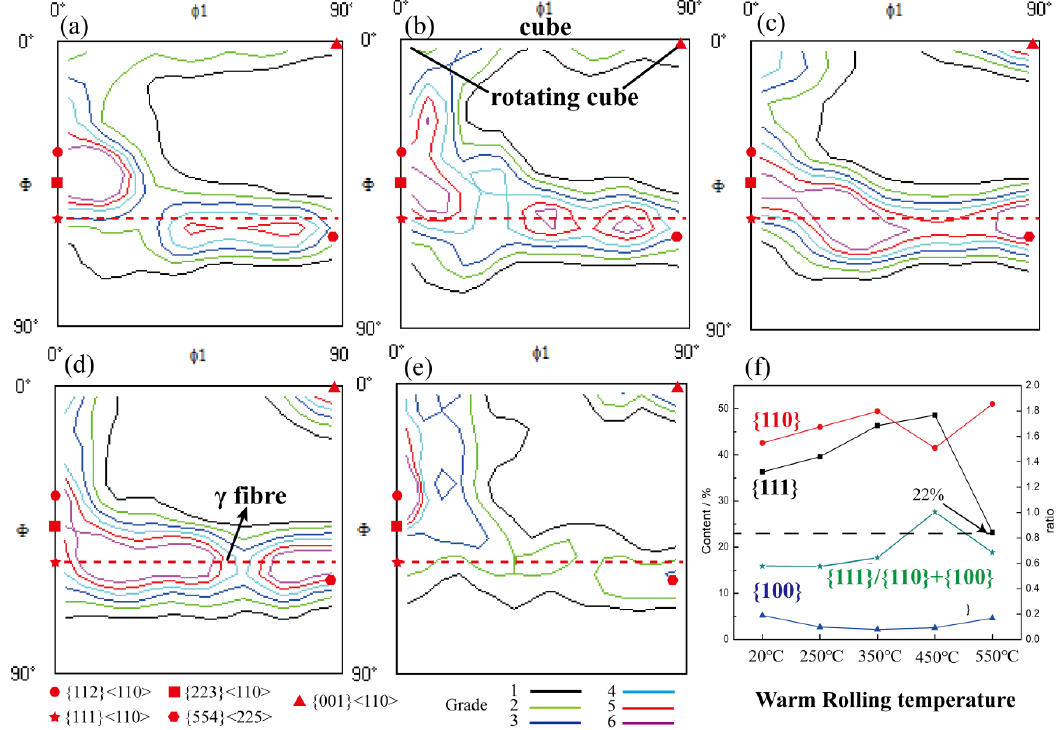
Figure 4. ODF (Orientation distribution function) diagram of the ϕ 2 = 45 ◦ section of the warm-rolled sheet. ( a ) RT; ( b ) 250 ◦ C; ( c ) 350 ◦ C; ( d ) 450 ◦ C; ( e ) 550 ◦ C; and ( f ) warm-rolled texture volume fraction.